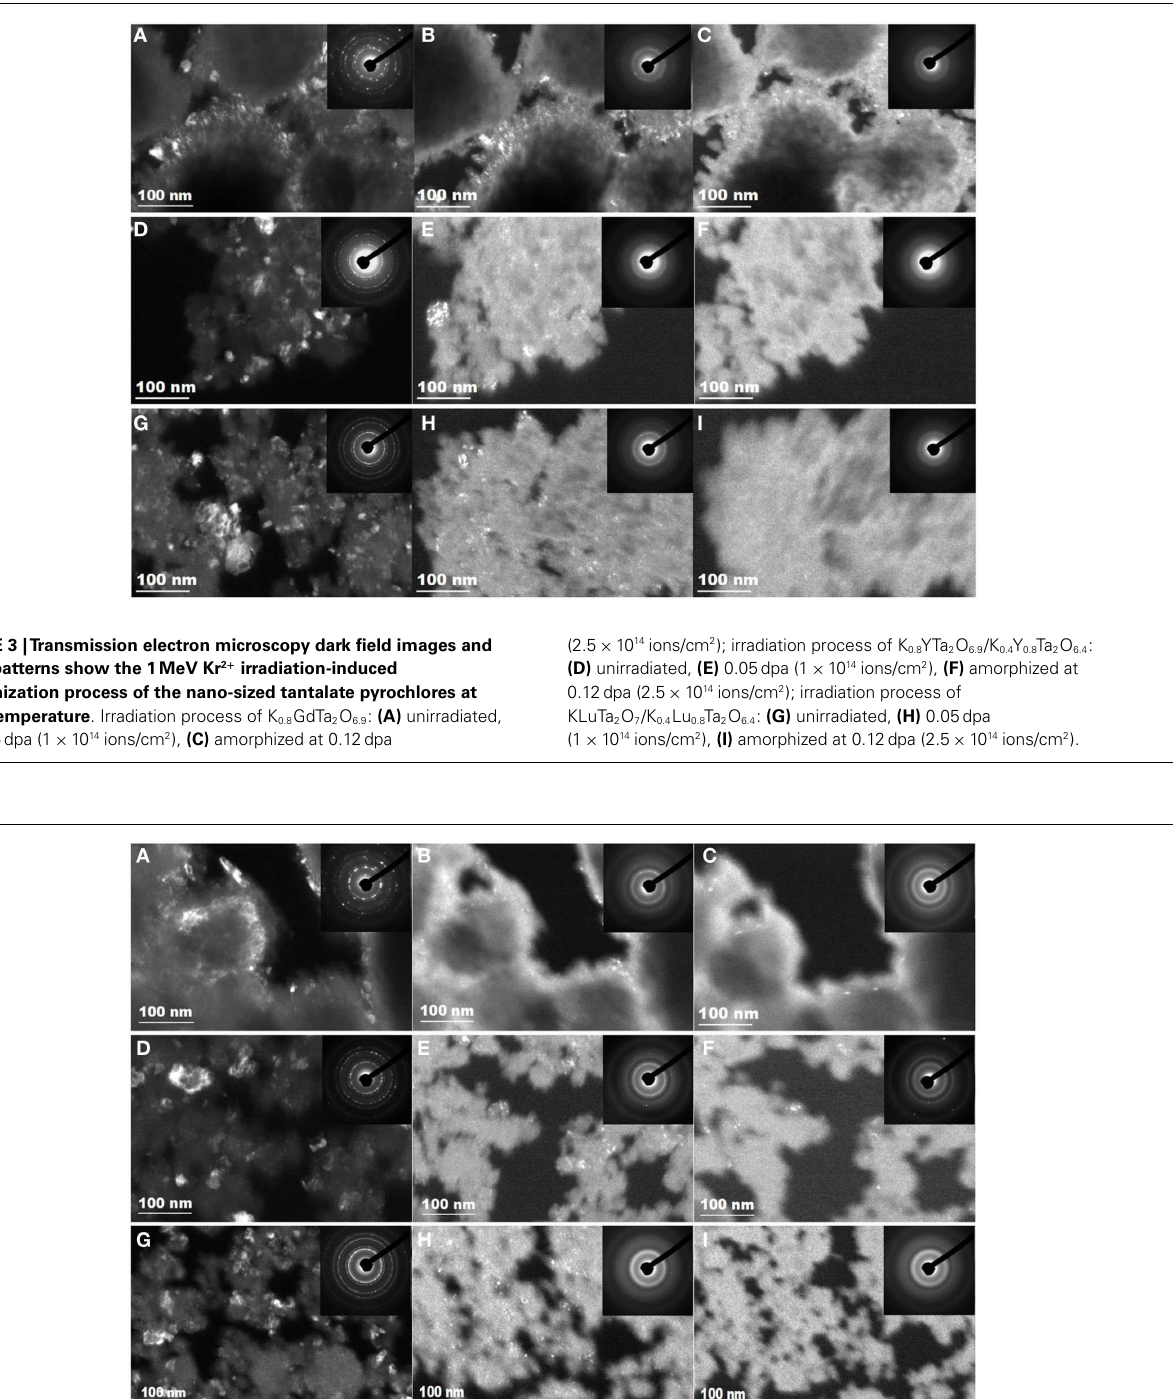
FIGURE 4 |Transmission electron microscopy dark field images and SAED patterns show the 1MeV Kr 2 + irradiation-induced amorphization process of the nano-sized tantalate pyrochlores at 873K . Irradiation process of K 0.8 GdTa 2 O 6.9 : (A) unirradiated, (B) 0.10dpa (2 × 10 14 ions/cm 2 ), (C) amorphized at 0.30dpa (6.25 × 10 14 ions/cm 2